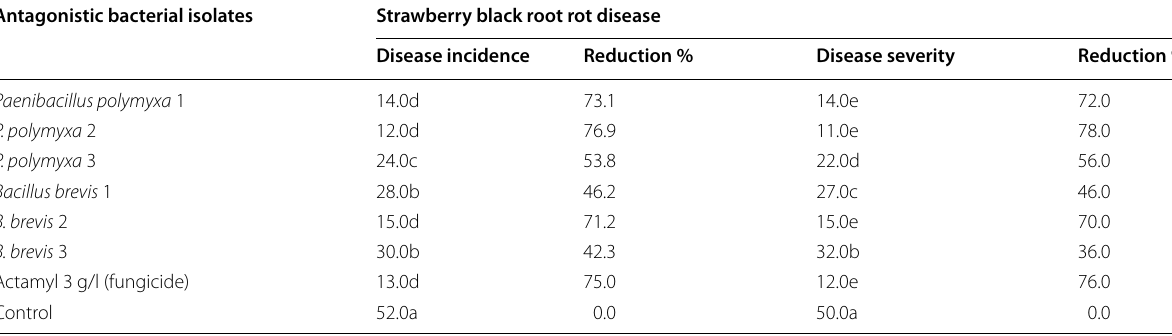
*Means in a column followed by the same letter are not significantly ( P